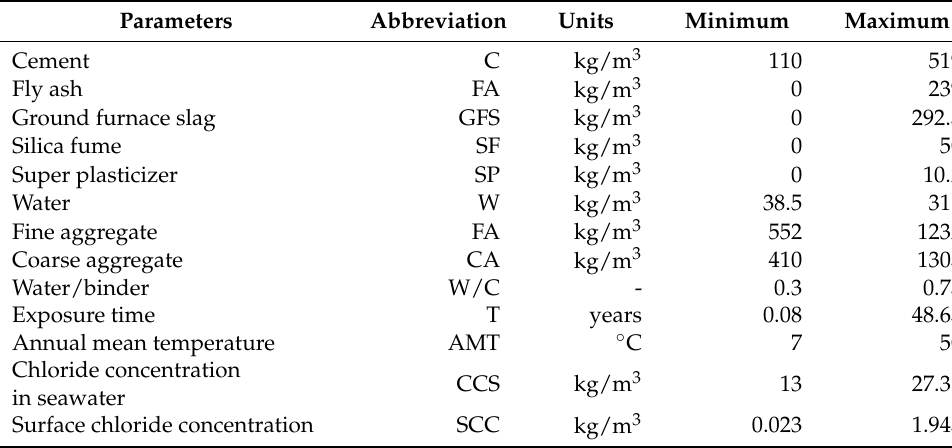
Figure 3. The distribution of input parameters used in the prediction of models. Table 2. Range of input and output variables.